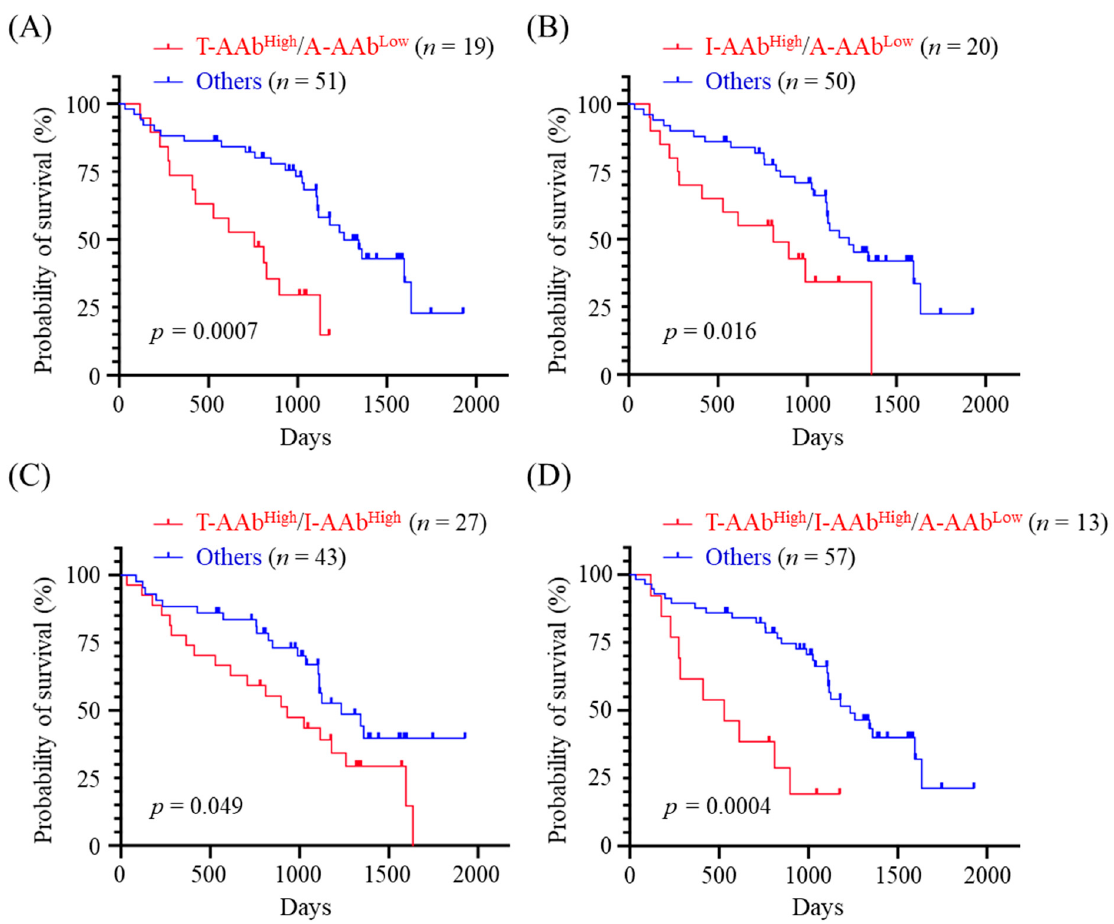
Figure 5. Correlation between the combined panels of serum AAb levels and OS of MMT dogs. Dogs with MMT ( n = 70) were dichotomized by a combination of ( A ) TYMS-AAb High and AGR2-AAb Low (denoted T-AAb High /A-AAb Low ), ( B ) IGFBP5-AAb High and AGR2-AAb Low (denoted I-AAb High /A-AAb Low ), ( C ) TYMS-AAb High and IGFBP5-AAb High (denoted T-AAb High /I-AAb Low ), and ( D ) TYMS-AAb High , IGFBP5-AAb High , and AGR2-AAb Low (denoted T-AAb High /I-AAb High /A-AAb Low ), respectively. OST of MMT dogs was compared between the dichotomous groups by using Kaplan-Meier analysis. Statistical significance was determined by the log-ranked test.